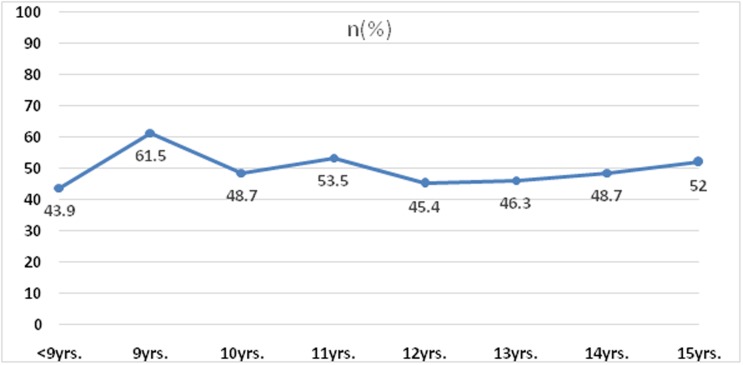
Age specific progression of myopia (n = 1279).